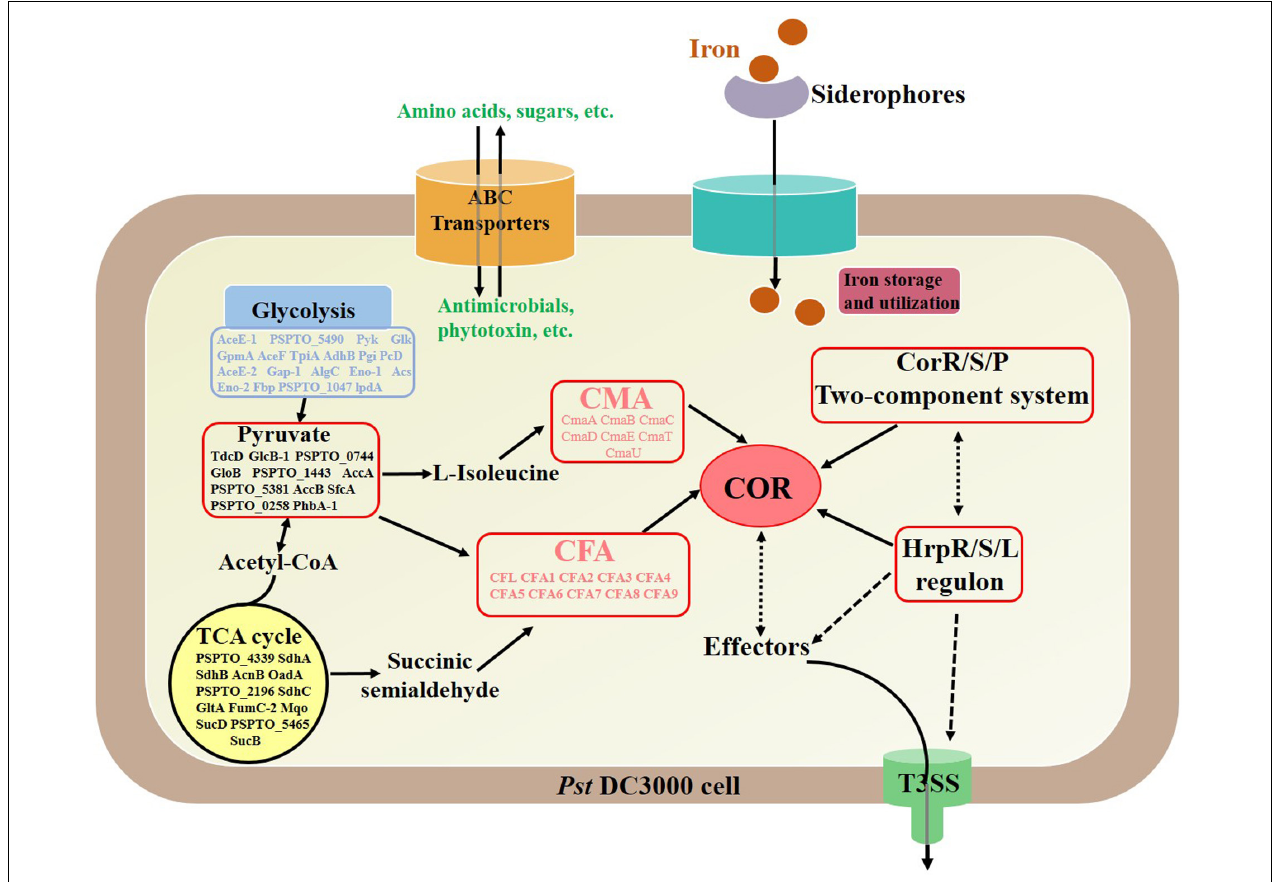
FIGURE 8 | Summary scheme showing the main differentially expressed proteins during coronatine synthesis under an iron fermentation environment. Solid line, direct relationship; dotted line, unknown indirect